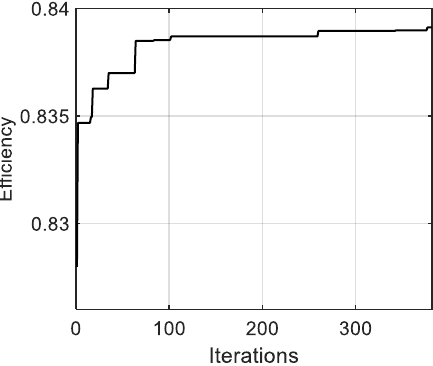
Figure 9. Iterative evolution curve.